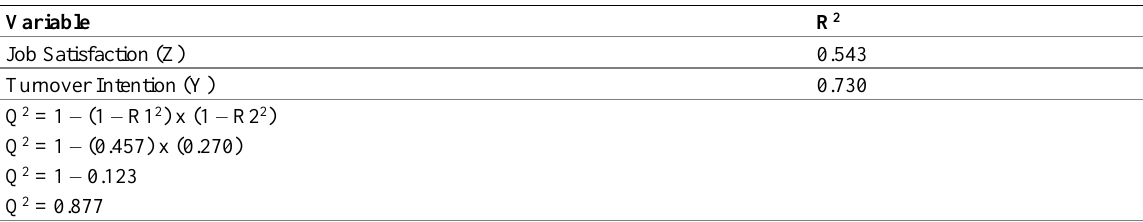
Table 5: Goodness of Fit